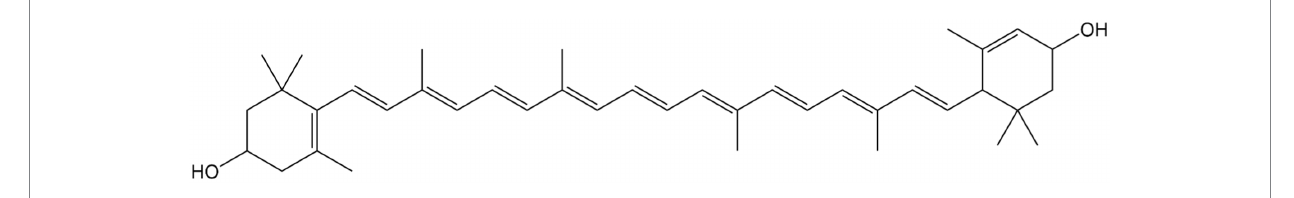
FIGURE 16 Chemical structure of lutein.